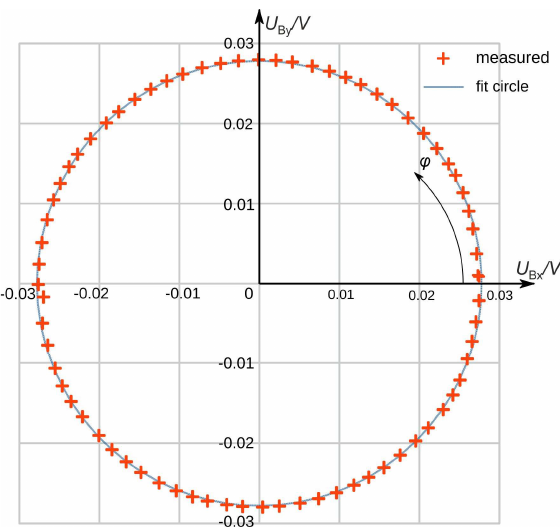
Figure 14. Measured directional diagram of a prototype of the advanced design aside with a circular fit. Zero-flow bridge offsets have been removed, the imposed average flow velocity was 1m/s. The circle corresponds to a perfect direction independent magnitude conversion. The observed magnitude variation as well as the corresponding azimuth deviations at a cross-sectional mean flow velocity of 1 m/s, visible in Figure 14, were much larger than the corresponding simulation results.